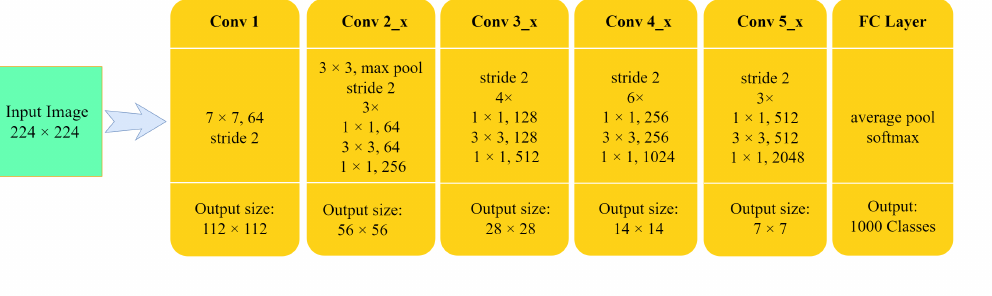
Figure 13. ResNet 50